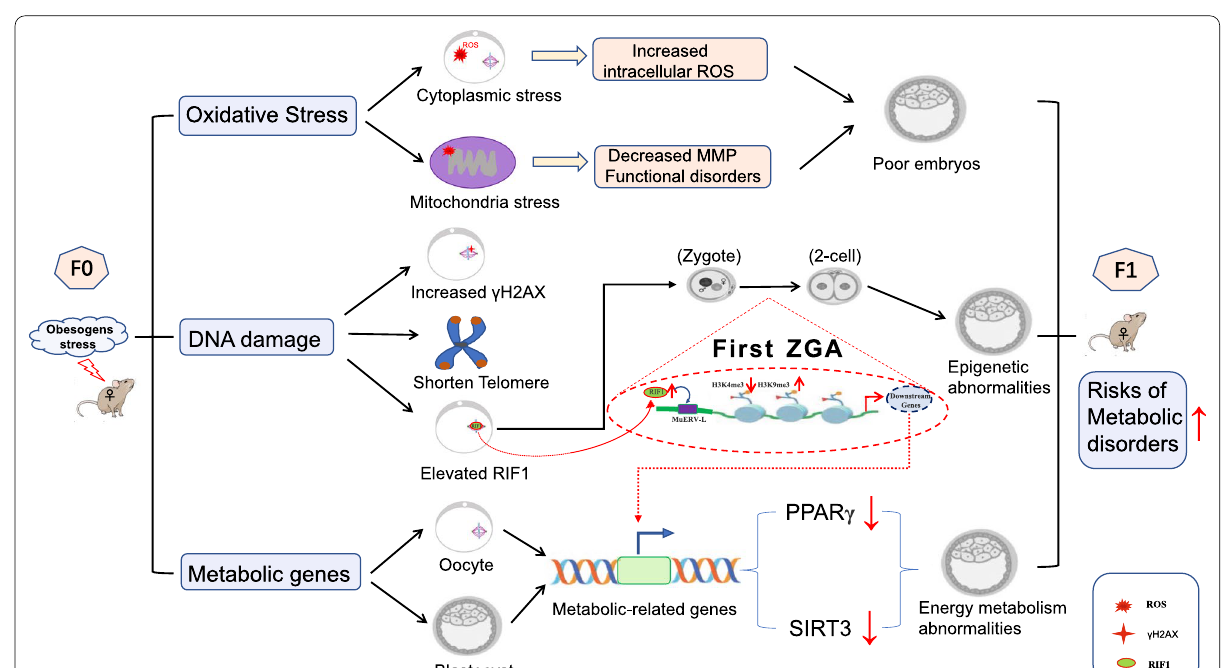
Fig. 6 Diagram summarizing the influencing factors of offspring phenotype and the proposed epigenetic mechanism in a HFD mouse